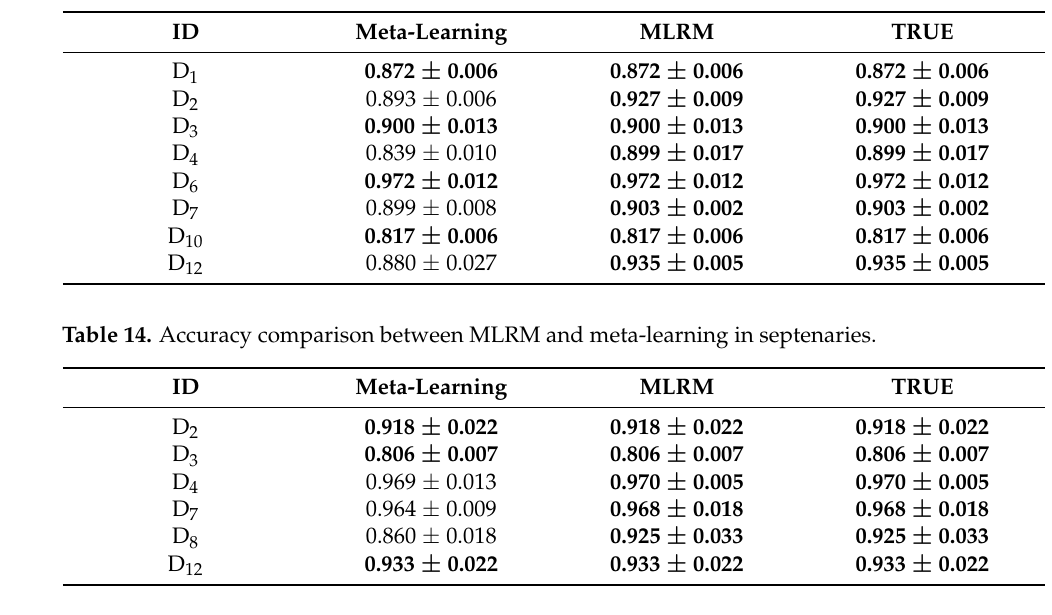
Table 13. Accuracy comparison between MLRM and meta-learning in senaries.